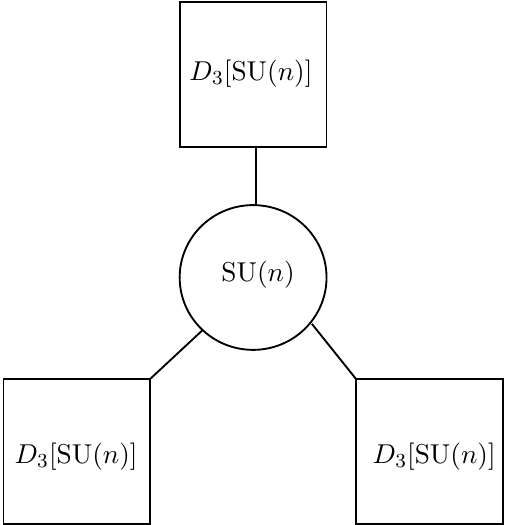
Figure 1 . The theory corresponding to singularity x 3 + y 3 + z 3 + t n = 0 can also be constructed by gauging three D [SU( n )] 3